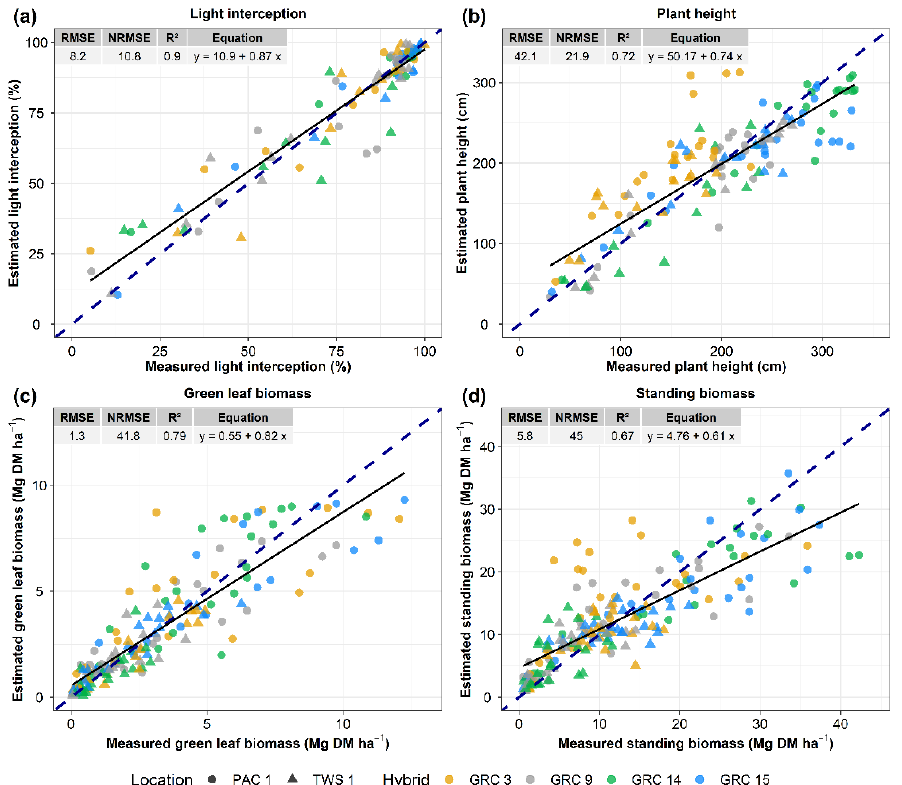
Figure 5. Estimated vs. measured crop traits on the ground of four Miscanthus hybrids’ growth at PAC 1 and TWS 1: ( a ) light interception (%), ( b ) plant height (cm), ( c ) green leaf biomass (Mg DM ha − 1 ), and ( d ) standing biomass (Mg DM ha − 1 ). The blue dashed line represents the 1:1 relationship and the black line represents the linear regression.